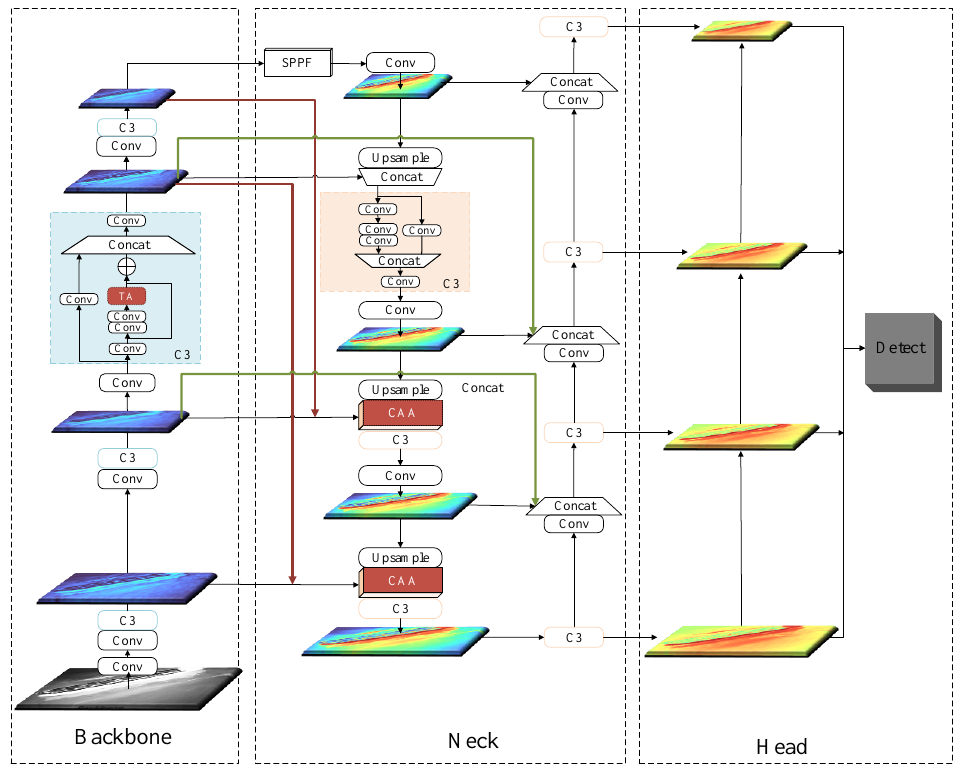
Figure 2. The framework of the